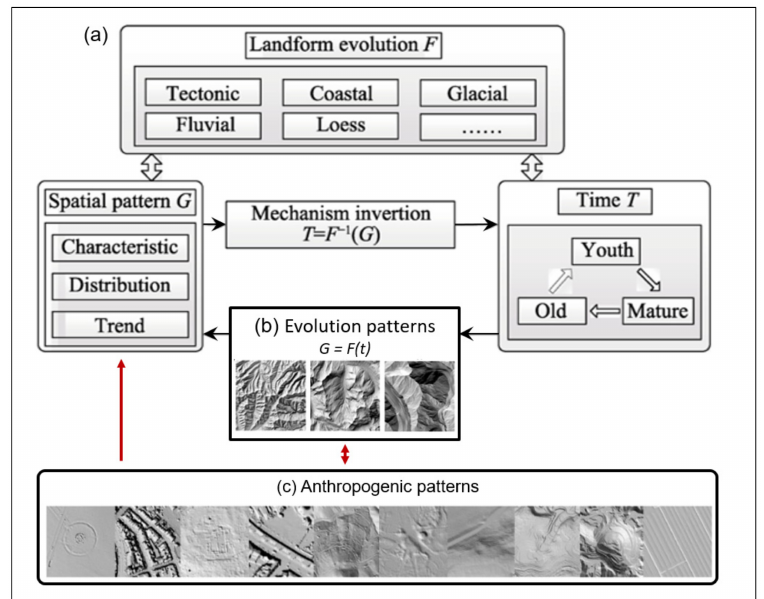
Figure 17. ( a ) Schematic diagram of space-for-time substitution from Huang et al. [126]; ( b ) evolution patterns of mountain types derived with RS, from Farmakis-Serebryakova and Hurni [98]; ( c ) examples of anthropogenic surface patterns derived with airborne LiDAR from Tarolli et al.